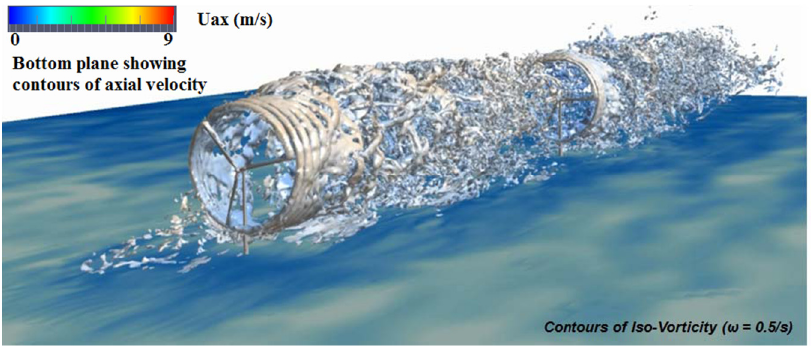
Figure 5. Turbine-Turbine interaction in NBL flow (NREL 5-MW Turbines, V Wind = 8